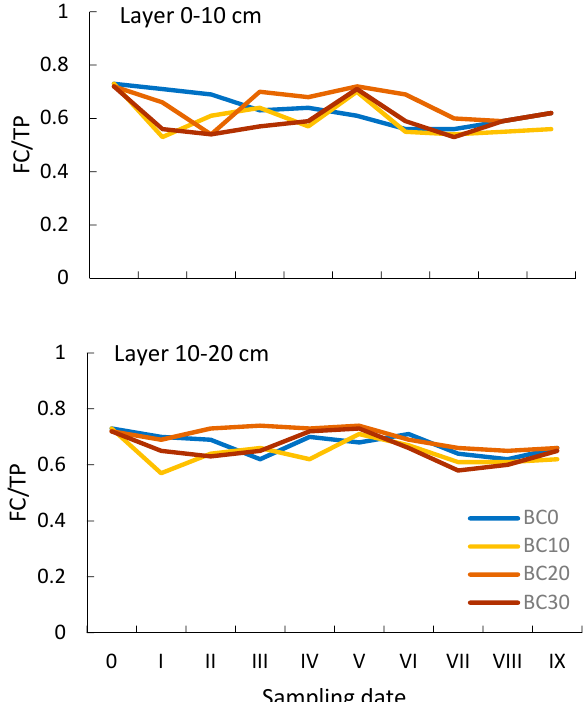
Figure 10. Ratio of field water capacity and total porosity (FC/TP). Explanations as for Figure 1.